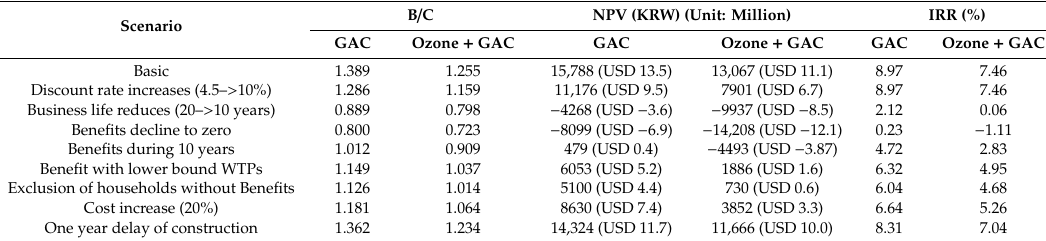
Table 13. Outline of the sensitivity